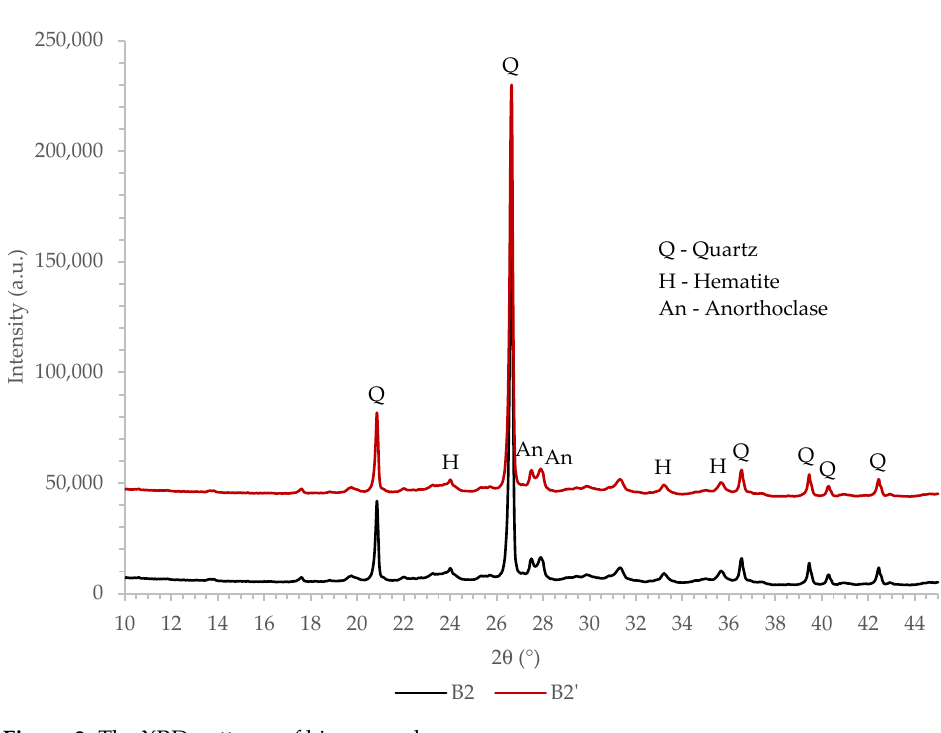
Figure 2. The XRD patterns of biomass ash.